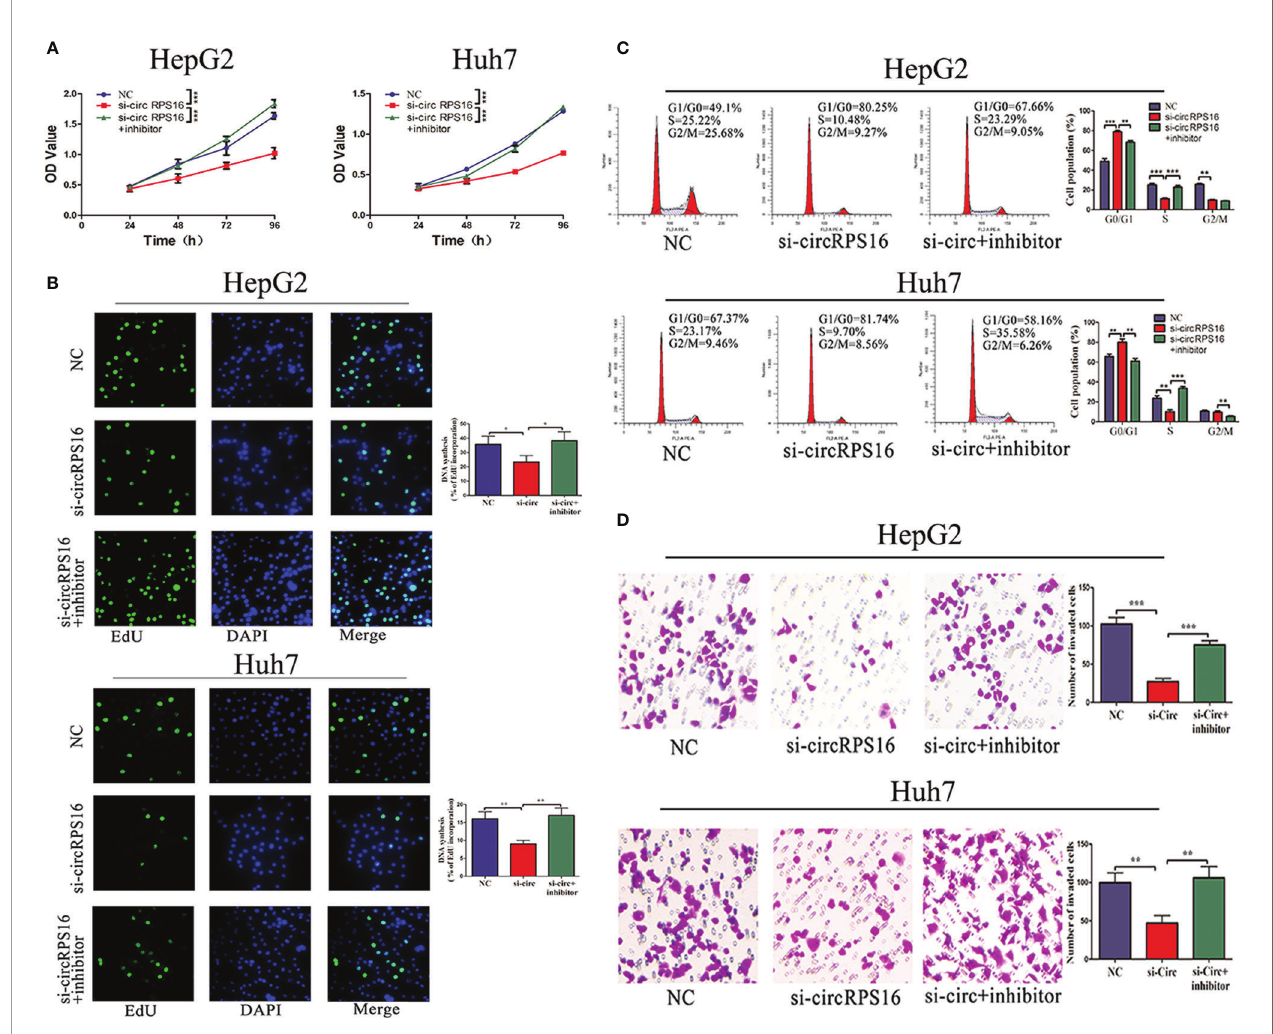
FIGURE 5 | circRPS16 regulates HCC cell proliferation, cell cycle, and invasion capacity via miR-876-5p. (A) CCK-8 and (B) EdU assays show that circRPS16 knockdown inhibited the proliferation of HCC cells and miR-876-5p inhibitor restored the proliferation of circRPS16 knockdown HCC cells. (C) Flow cytometry reveals that circRPS16 knockdown induced cell cycle arrest and miR-876-5p inhibitor accelerated cell cycle of circRPS16 knockdown HCC cells. (D) Transwell assays show that circRPS16 knockdown inhibited invasion capacity of HCC cells and miR-876-5p inhibitor restored invasion capacity of circRPS16 knockdown HCC cells. All the above experiments were repeated three times independently; data are presented as mean ± SD; statistical signi fi cance was assessed by Student ’ s t -test. * p < 0.05, ** p < 0.01, *** p < 0.001. NC, negative control; si,